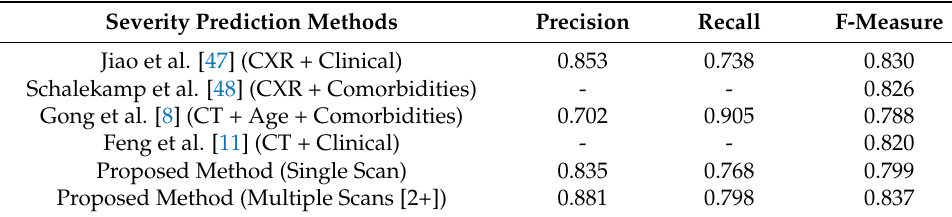
Table 5. Comparison of the proposed method with similar existing